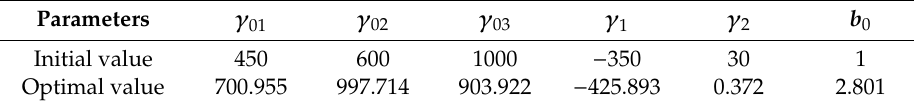
Table 1. ADRC controller parameter optimization